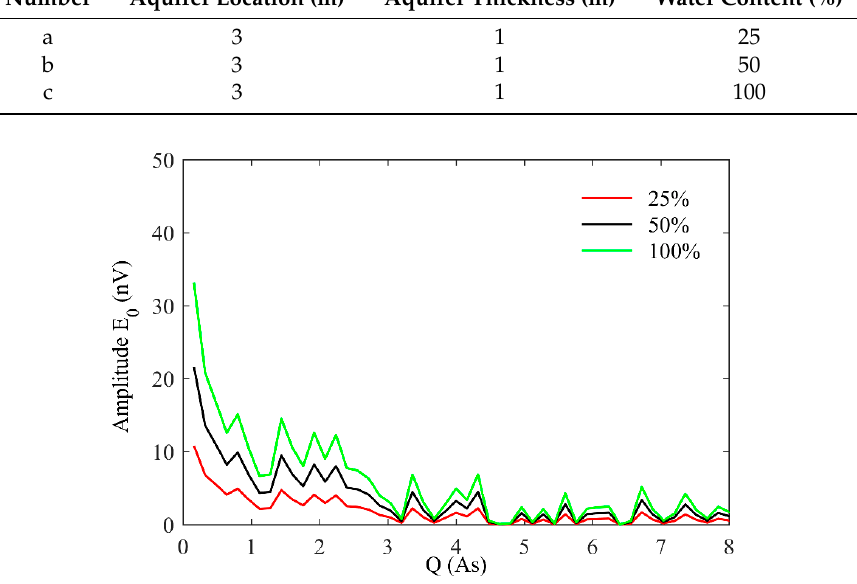
E q − with varying water content of 25%, 50% and 0